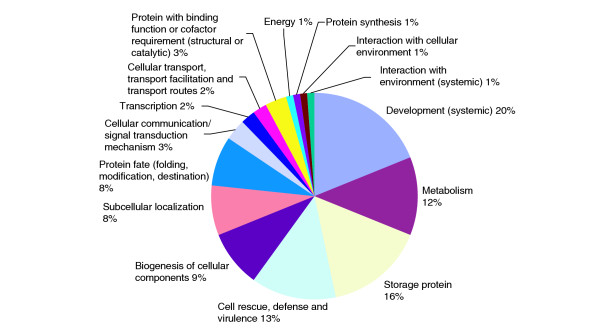
Functional distribution of genes that are differentially regulated by accession-by-organ interactions. Fifty-two genes, identified by two-way ANOVA analysis, were subjected to MIPS functional classification based on their annotations.